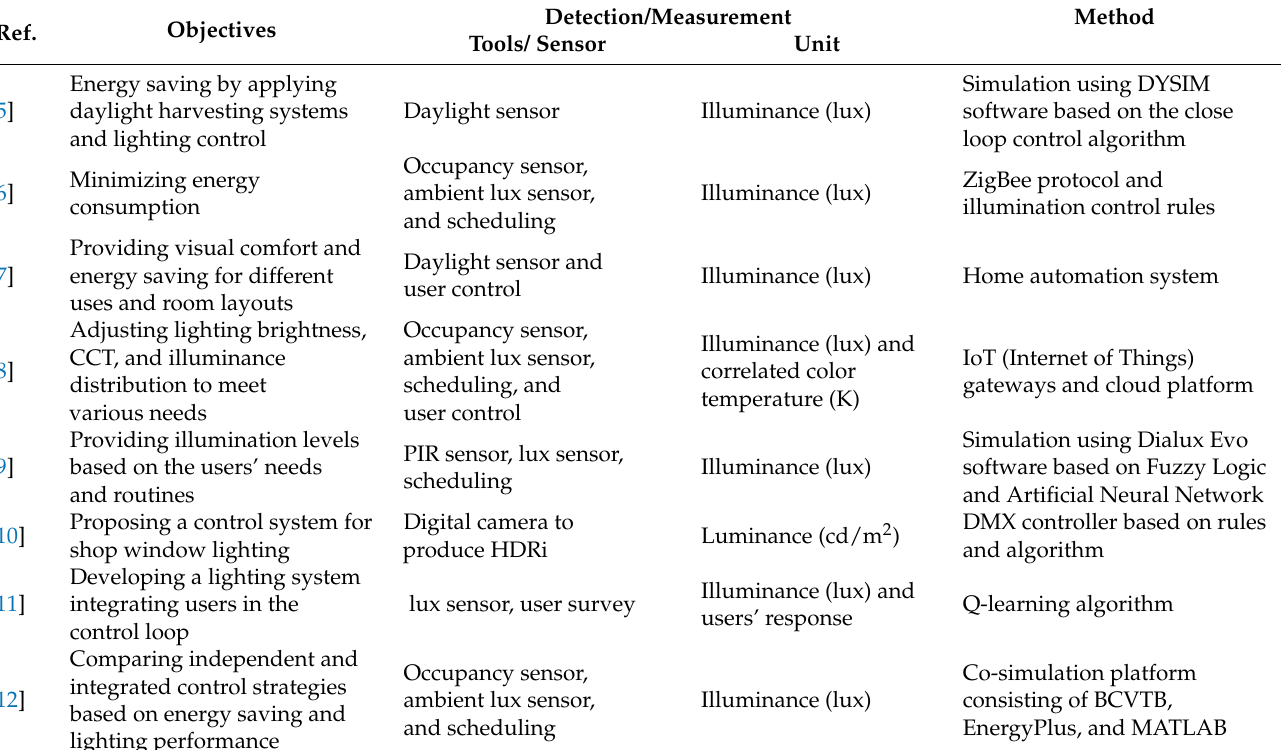
Table 1. Selected research and their techniques of